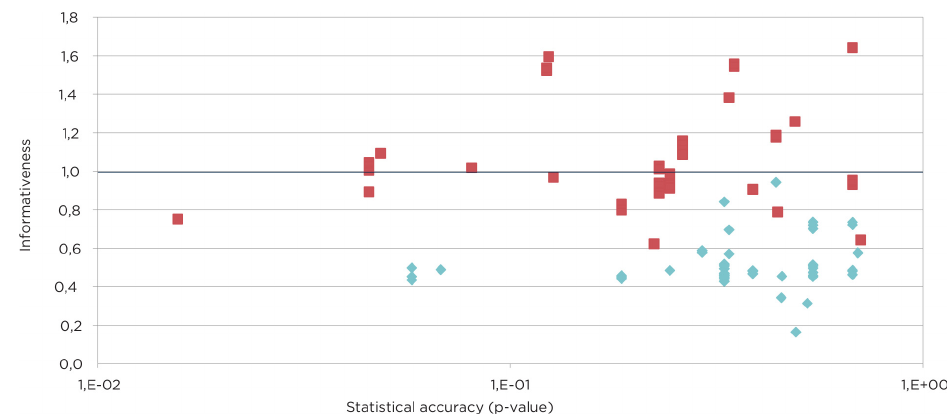
Fig 2. Statistical accuracy versus informativeness of the included experts when using equal weight (blue) or performance weight (red) combinations,